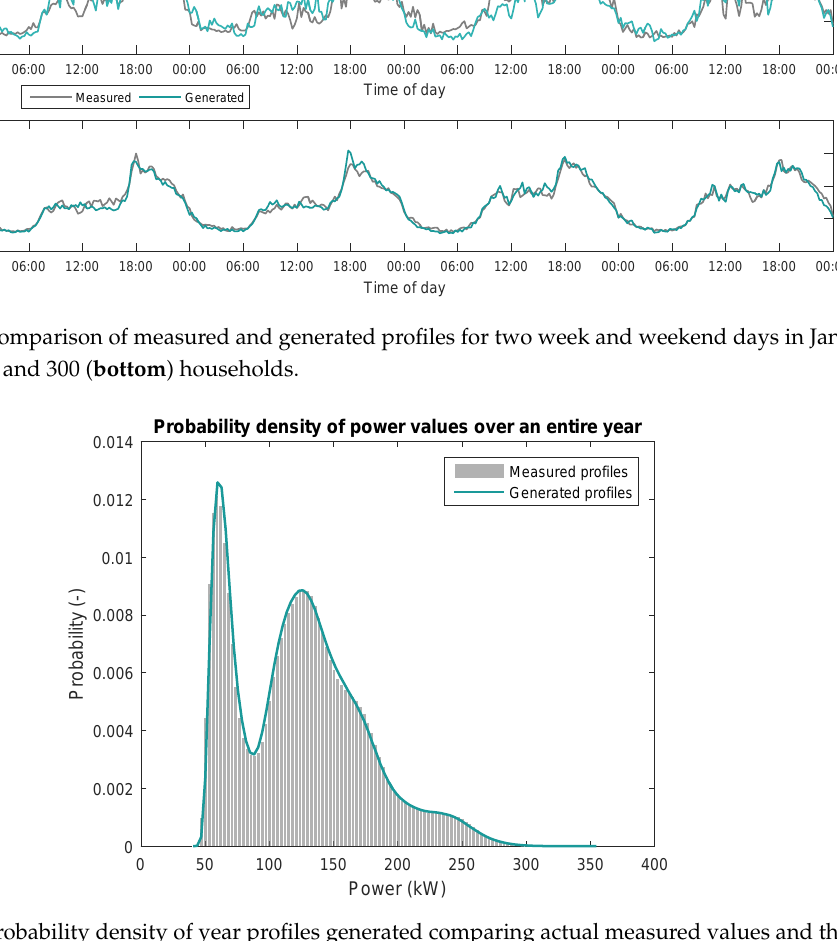
Figure 5. Probability density of year profiles generated comparing actual measured values and the the generated day